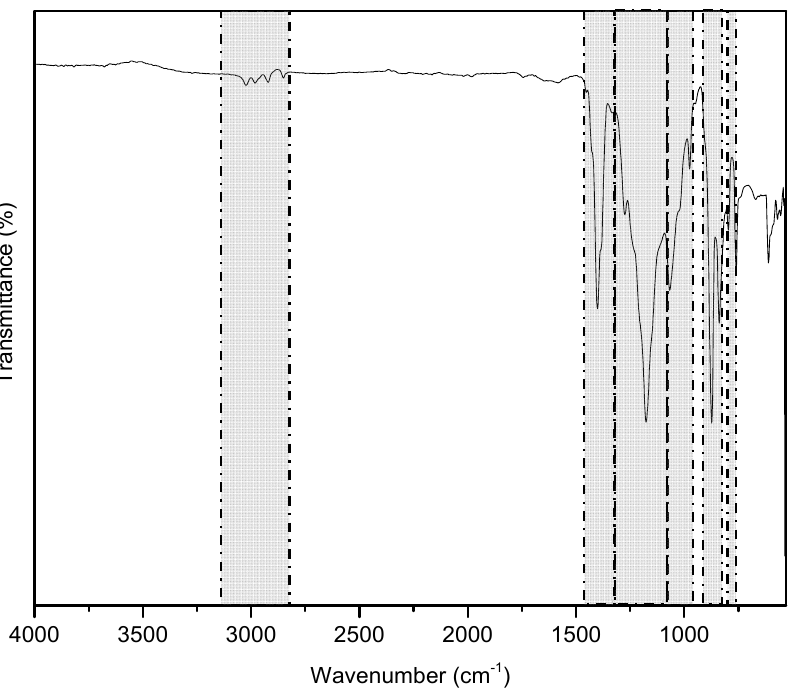
Figure 4. FTIR spectra of N-doped TiO 2 / PVDF DLHF membranes scanned with the wave number ranging from 650 to 4000 cm − 1 .